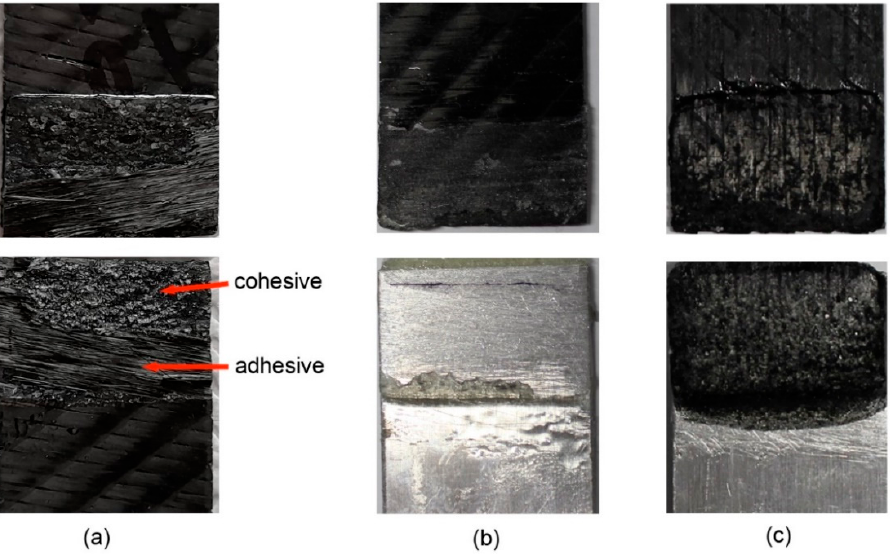
Figure 14. Representative fracture surfaces of ( a ) CFRP/CFRP joints, ( b ) CFRP/Aluminium with neat adhesive and ( c ) CFRP/Aluminium with 0.1 wt% GLYMO-rGO in adhesive.